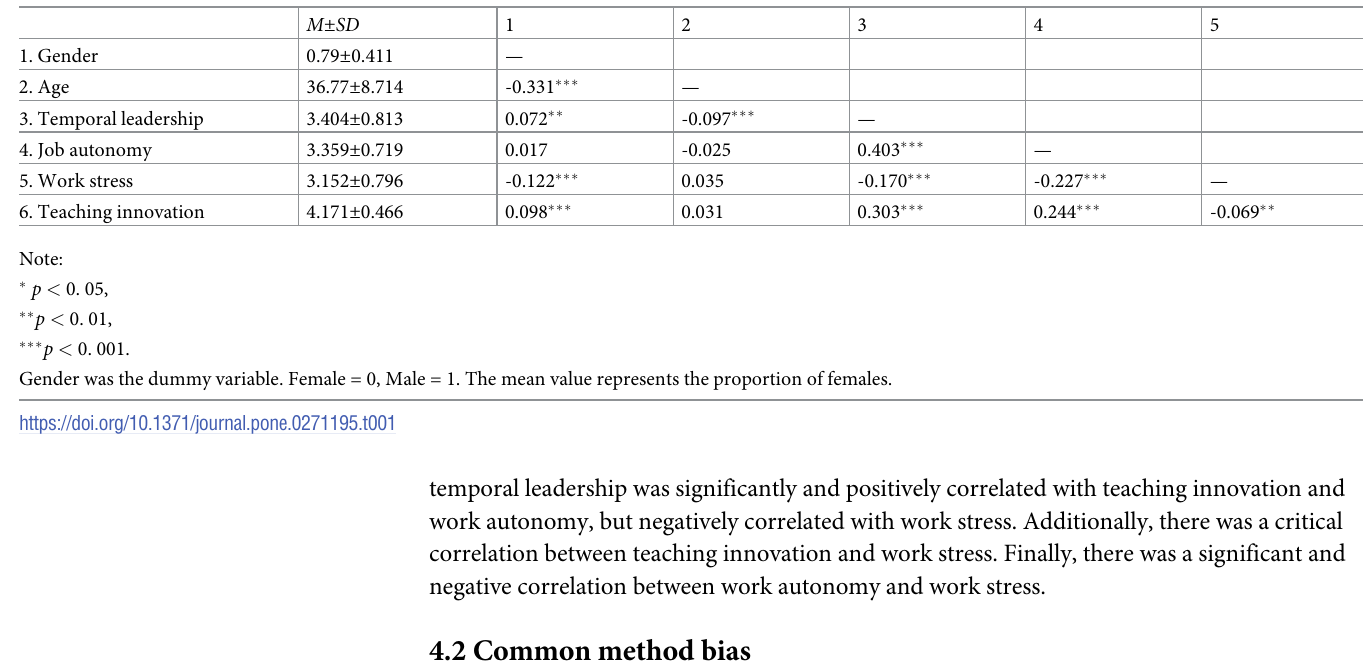
Table 1. Mean values, standard deviations, and correlation matrixes among